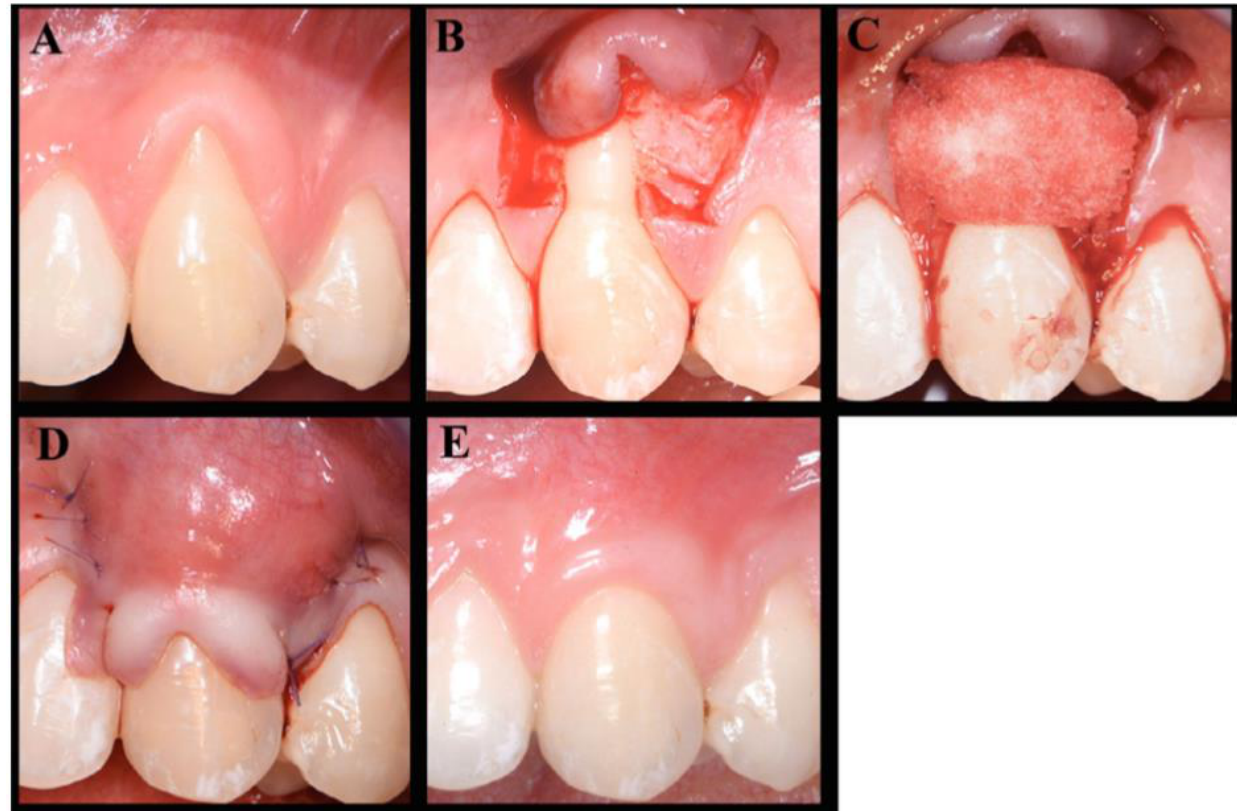
Figure 5. Volume-Stable Collagen Matrix for Periodontal Plastic Surgery. ( A ) Gingival recession defect on a maxillary canine ( B ) A split-full-split flap limited to the canine was performed ( C ) After the de-epithelialization of the anatomical papillae, a volume-stable collagen matrix was applied on the root surface and sutured to the de-epithelialized papillae ( D ) The flap was coronally advanced and sutured ( E ) One-year outcomes. Reprinted from [125] with permission from Wiley.